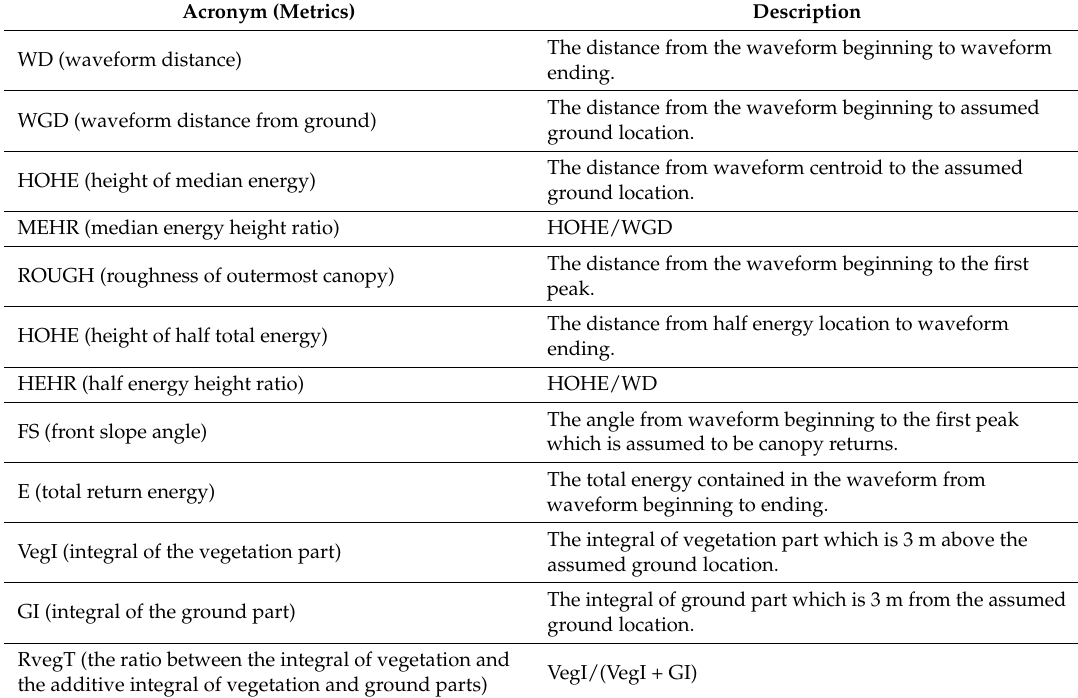
Table 3. Description of main variables extracted from waveform signatures and point